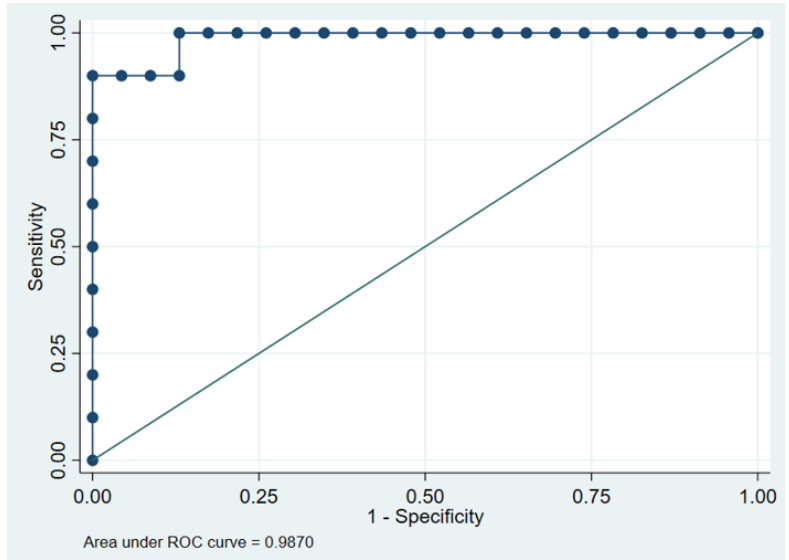
Figure 3. Receiver operating characteristics curve analysis of FVF for diagnosing fatty liver.